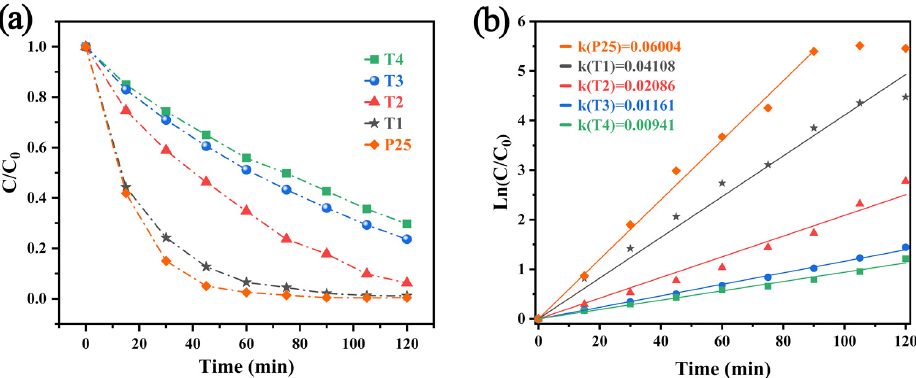
Figure 6. Photocatalytic activity: ( a ) degradations of Tetracycline hydrochloride, ( b ) kinetic linear fitting curves.